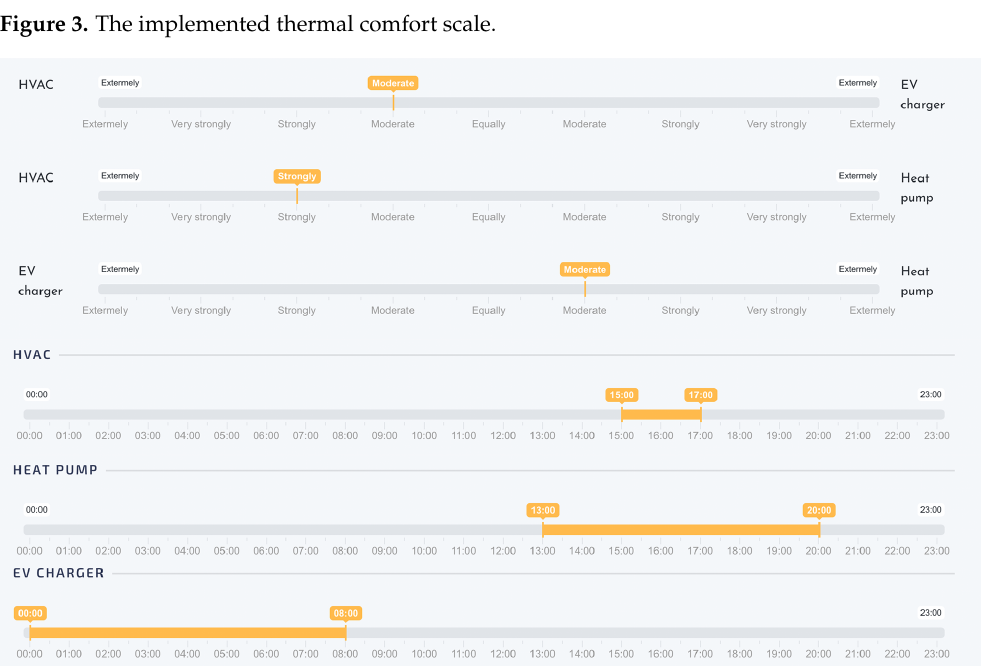
Figure 4. The implemented 9-pointed importance